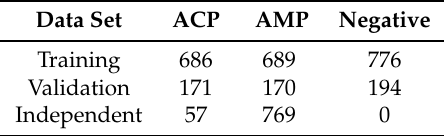
Table 1. Data set sizes used for training and validation of CancerGram.